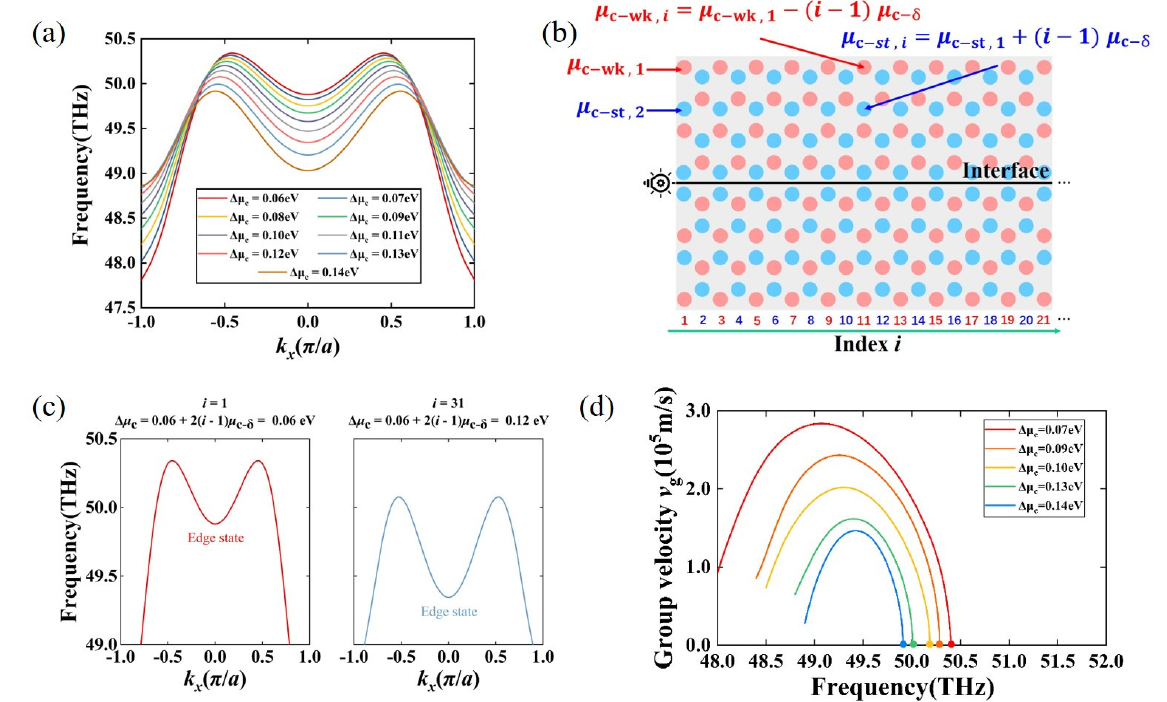
Figure 4. ( a ) Evolution of valley topological edge states with respect to the chemical potential difference ∆ µ c . With the increases of ∆ µ c , the edge state frequencies at the highest point gradually decreased. ( b ) Configuration of the chirped valley GPC edge state interface waveguide. Surface plasmon polariton (SPPs) wave along a straight interface exited on the left. The red and blue circles represent the graphene nanodisks of weak chemical potentials µ c − wk , i and strong chemical potentials µ c − st , i . The weak and strong chemical potentials change as i increases as follows: µ c − wk , i = µ c − wk ,1 − ( i − 1 ) µ c − δ and µ c − st , i = µ c − st ,1 + ( i − 1 ) µ c − δ . The graphene nanodisks of weak and strong chemical potentials in the first column were µ c − wk ,1 = 0.27 eV and µ c − st ,1 = 0.33 eV, respectively. The step size µ c − δ was 0.005 eV. ( c ) Dispersion relation curves of the supercell with the chemical potential difference ∆ µ c = 0.06 eV in the 1st column and ∆ µ c = 0.12 eV in the 31st column. ( d ) Dispersion curves of valley edge state group velocities v g for the valley topological interface with ∆ µ c from 0.07 eV to 0.14 eV .